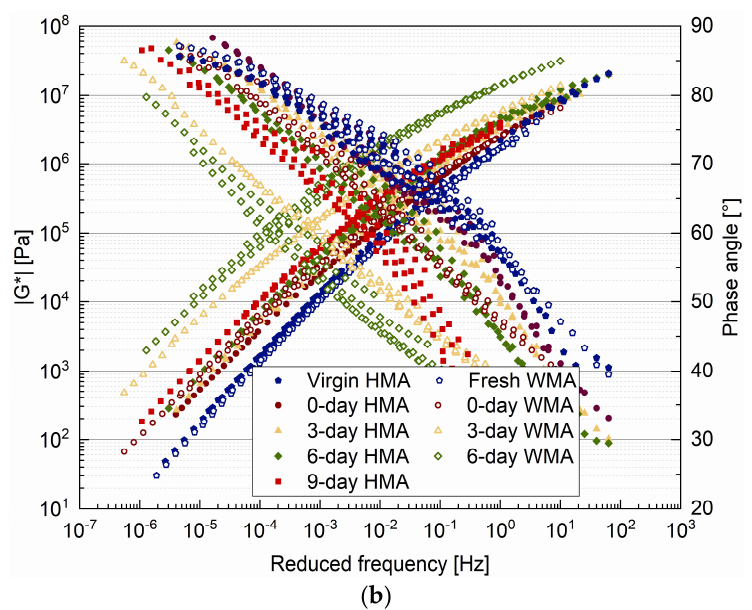
Figure 6. Master curve of ( a ) HMA binders and ( b ) WMA binders before and after ageing. Ascending curves represent complex moduli |G*| while descending curves represent the phase angle.